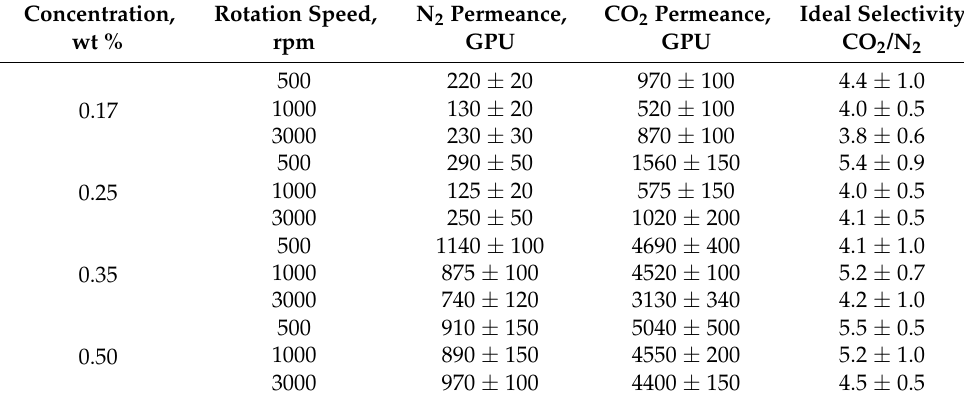
Table 3. Gas transport properties of composite PTMSP/MFFK-1 membrane obtained by applying PTMSP solutions of various concentration ( ω =1000 and 1500